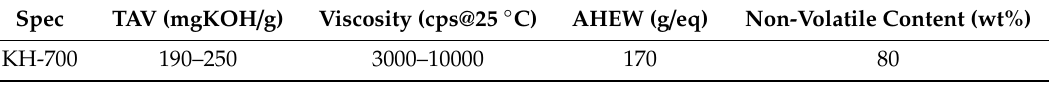
Table 3. Physical and Chemical Properties of the Hardener Used in the Experiments.